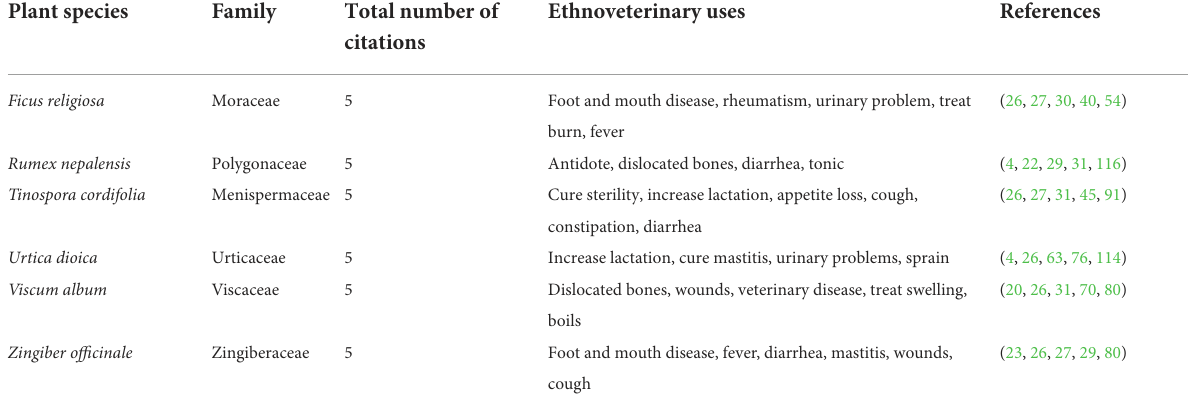
TABLE 4 Number of plant species used to treat various livestock ailments/uses. Ailment